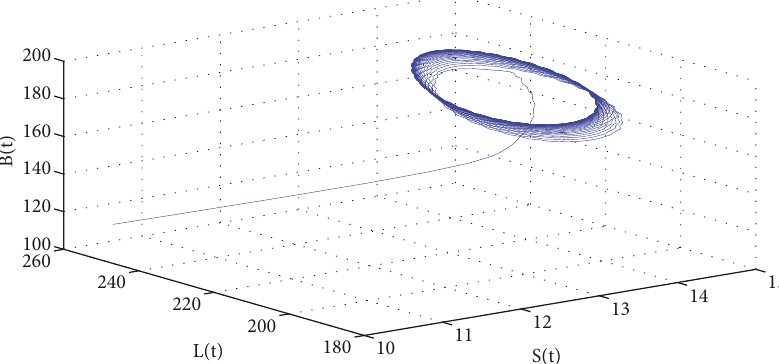
Figure 5: Dynamic behavior of system (61): projection on S-L-B with 𝜏 = 3.6755 > 𝜏 0 = 3.4685